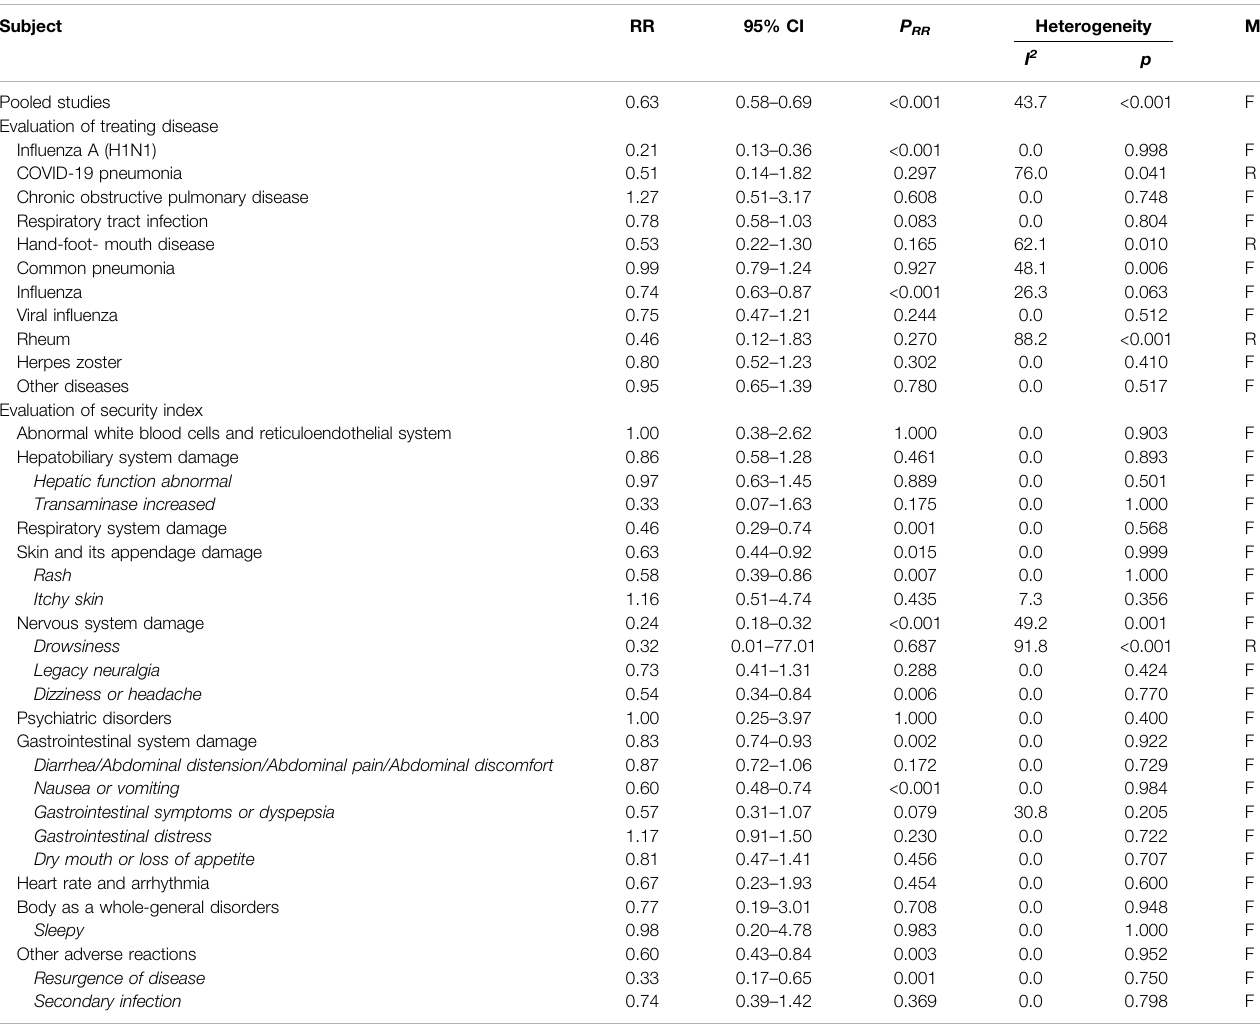
TABLE 1 | The quantitative analysis of all eligible